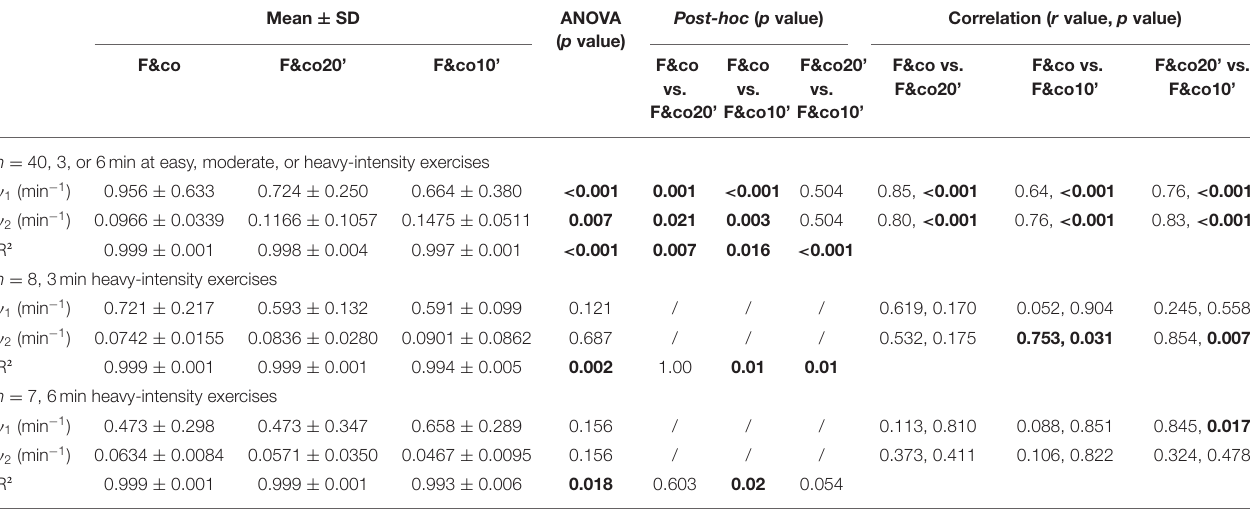
TABLE 5 | Mean values of the velocity constants γ 1 and γ 2 along with the R 2 values of the fits on the experimental data of Freund et al. (1989). Mean ±